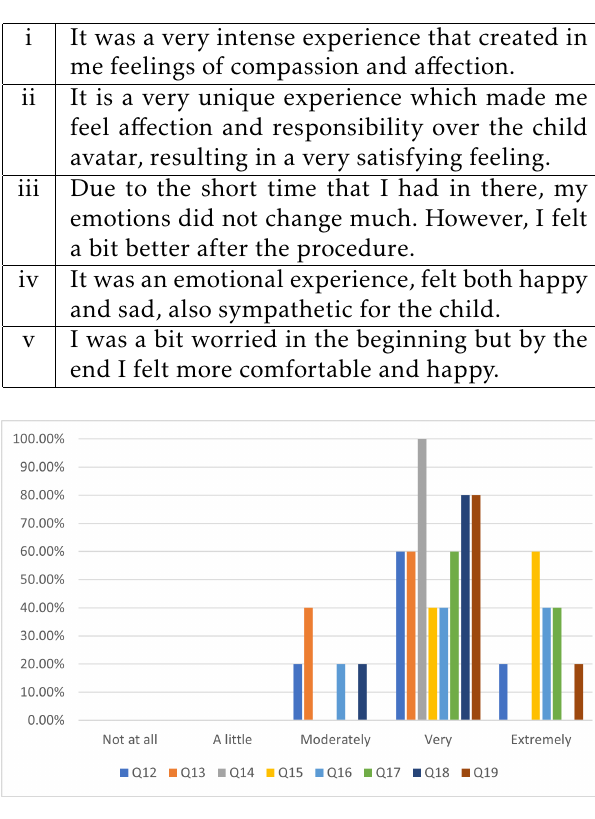
Figure 7. Overall percentage selection for questions Q12 to Q19 in Table